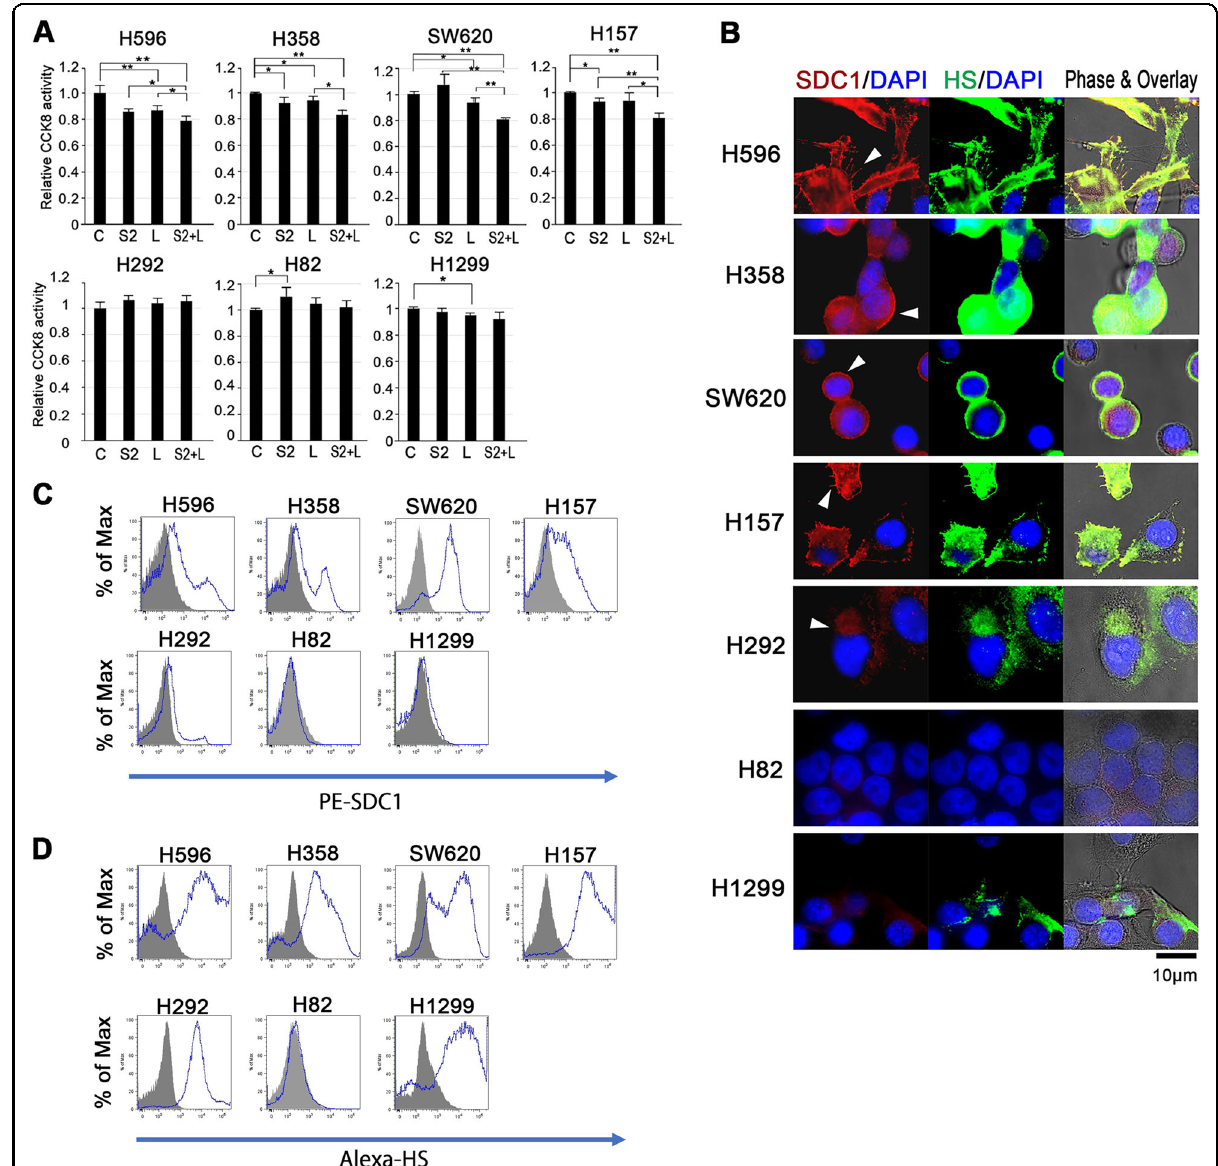
Fig. 2 Examination of human cancer cells for cell growth and expression pattern of SDC1 and HS. A Representative CCK8 analysis results. Average ± SD from more than three independent experiments. C, control; S2, SCGB3A2; L, LPS. * P < 0.05, ** P < 0.01 by one-way ANOVA. B Representative immuno fl uorescence analysis. Counter stained with DAPI. Bar = 10 µm. White arrowheads indicate the membranous SDC1 expressions. C , D Flow cytometric analysis for SDC1 and HS expression on cell surfaces of human malignant cells using anti-SDC1 ( C ) and anti-HS antibody ( D ). Gray histograms indicate unstained negative control. Experiments were carried out more than three times and at each time, similar results were